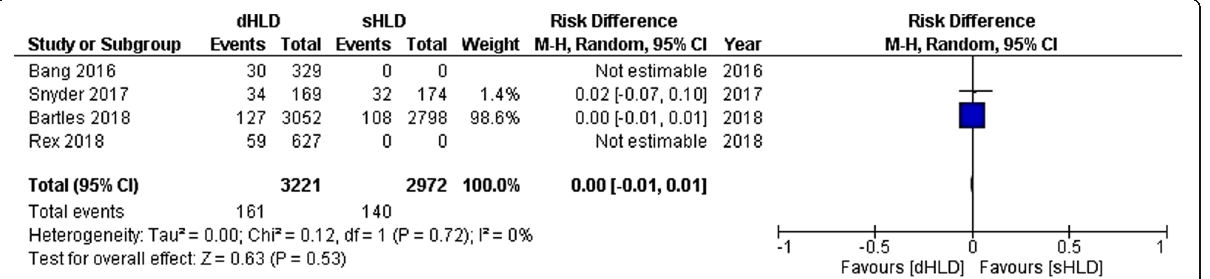
Fig. 3 Forest plot of comparison: risk difference for a positive